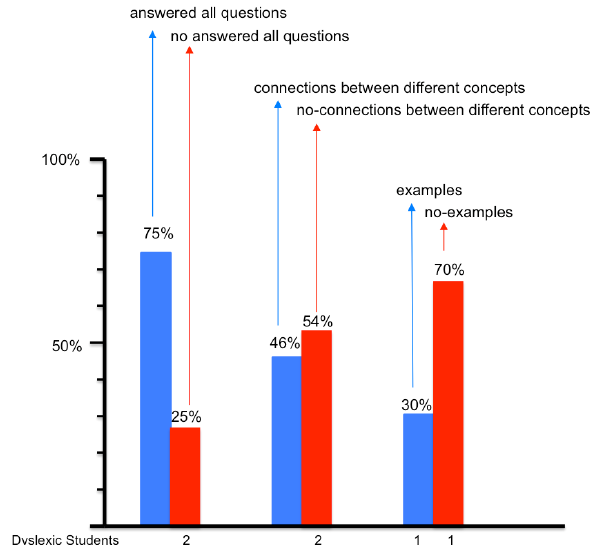
Figure 2. Results of the first examination.